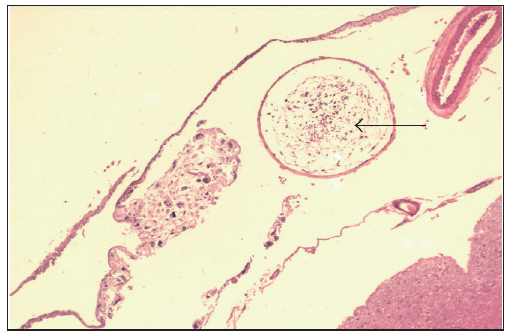
Figure 2: Liposarcoma cells seen within a blood vessel in the sub- arachnoid space.